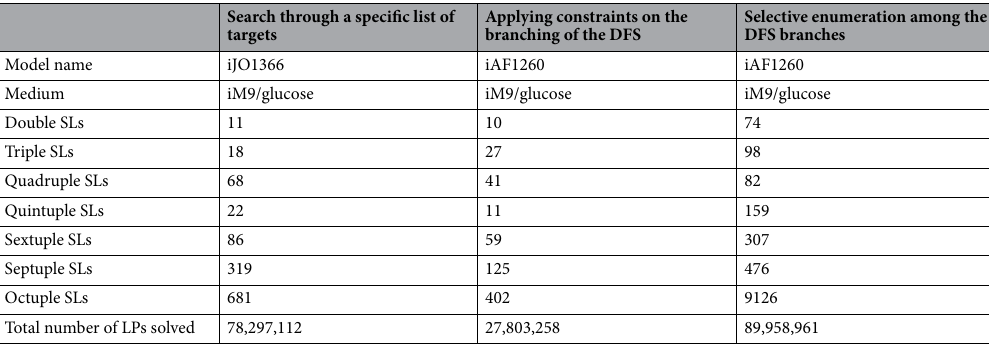
Table 4. Results of three introduced applications.